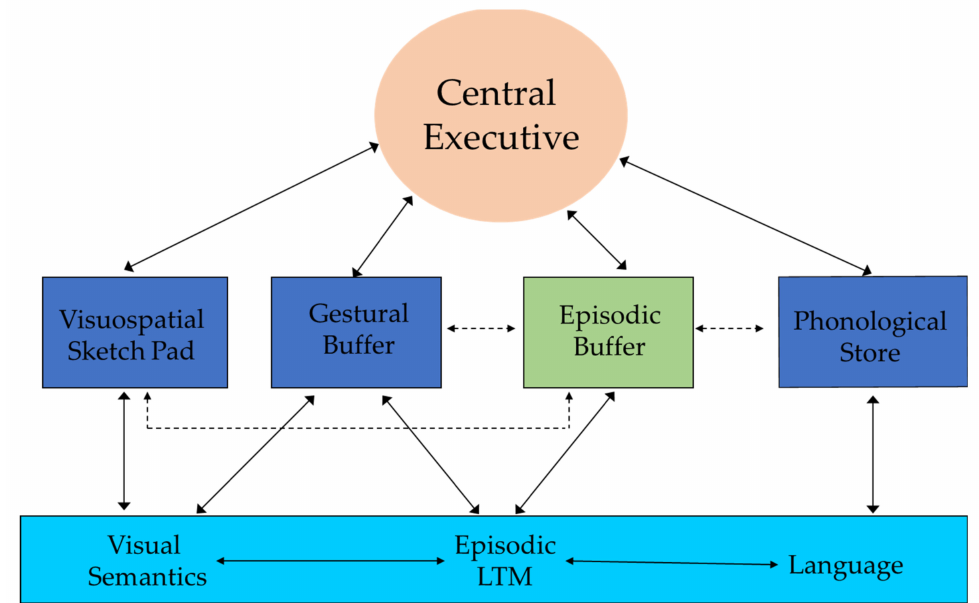
Figure 1. An implemented version of Baddeley’s model [28] of WM is proposed. This includes the two STM subsystems specific for visuo-spatial information and auditory-verbal information postulated by Baddley and an STM subsystem specific for visuo-motor information, i.e., the gestural buffer